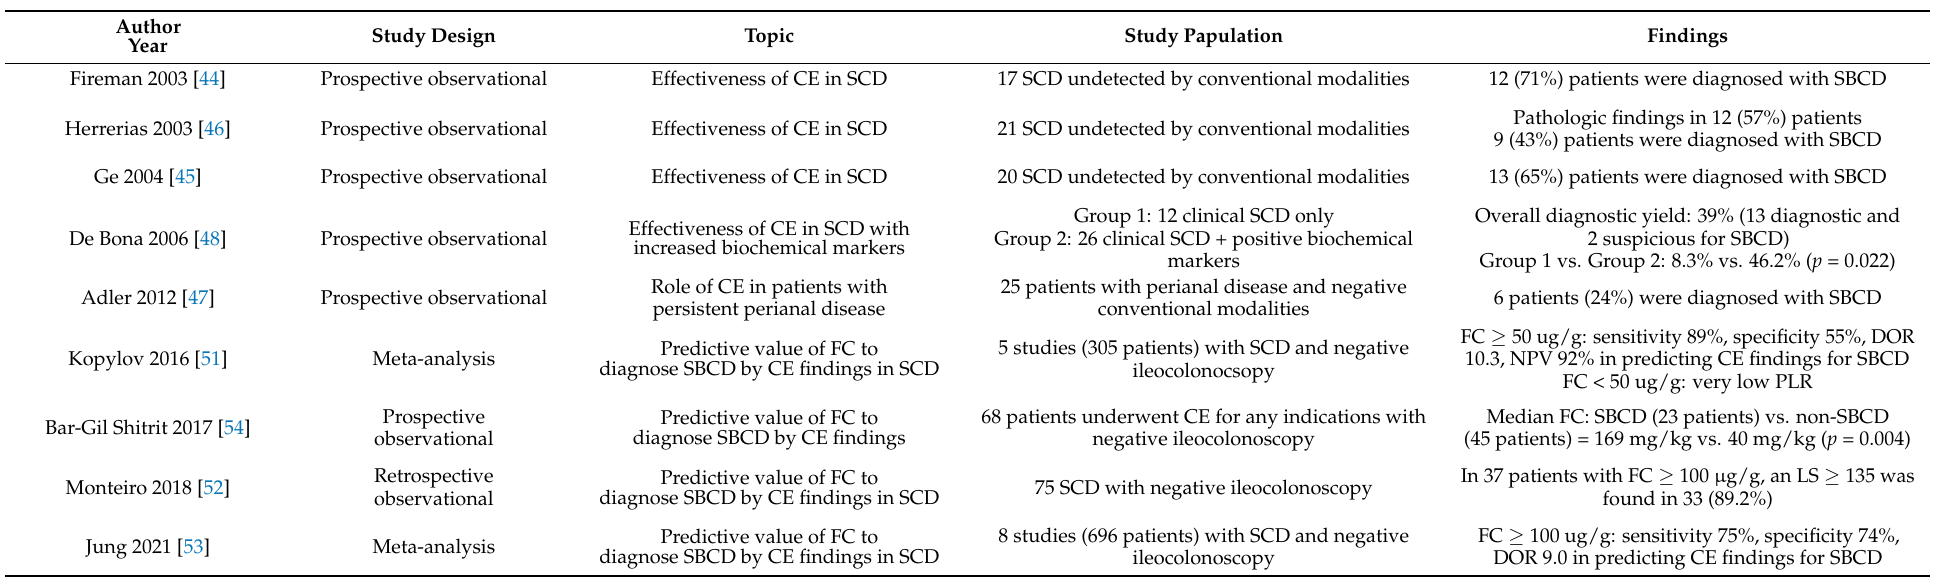
Table 1. Summary of results of studies on the clinical usefulness of capsule endoscopy for the evaluation of suspected Crohn’s